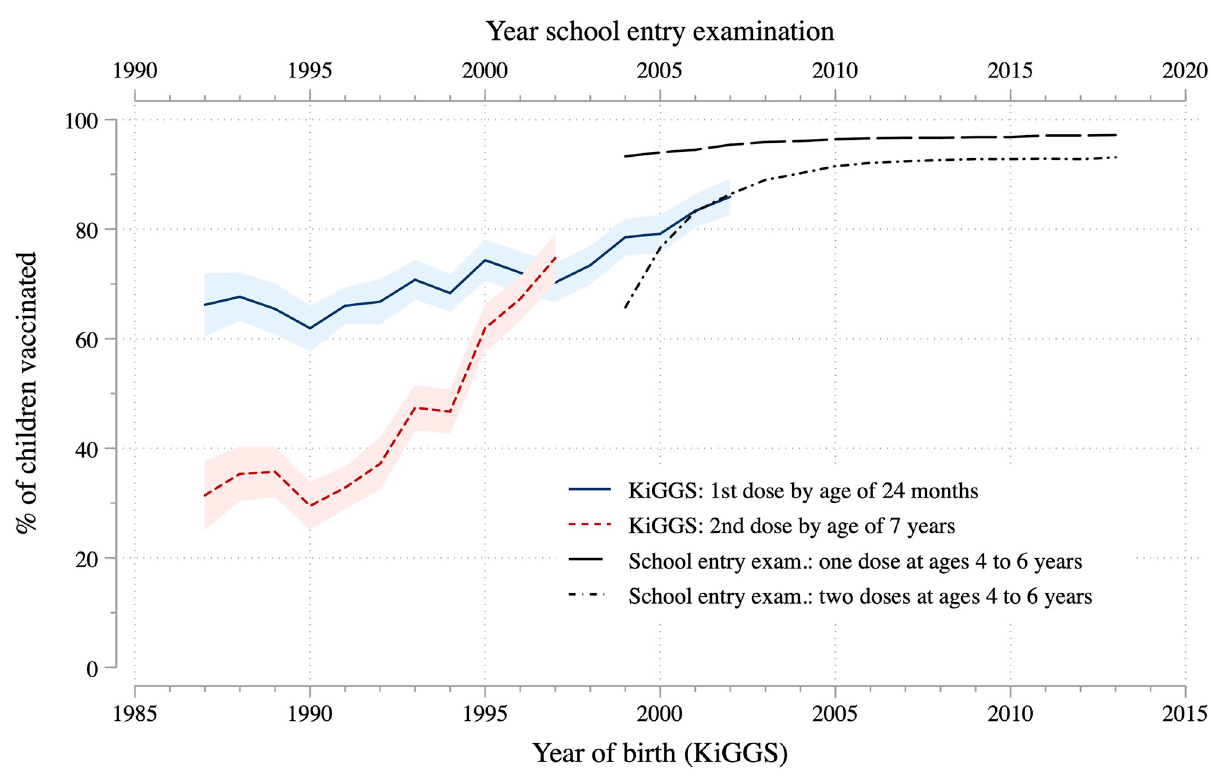
Fig 2. Measles vaccination rates over time. KiGGS data weighted, 14,007 observations for first measles dose by age 24 months (between 535 and 991 observations per year of birth) and 9,715 observations for second dose by age 7 years (between 535 and 975 observations per year of birth), point estimates and 95 percent confidence intervals. Note that in the school entry exam data in 2004 only, vaccination rates for two states (Saxony and Rhineland-Palatine) were not